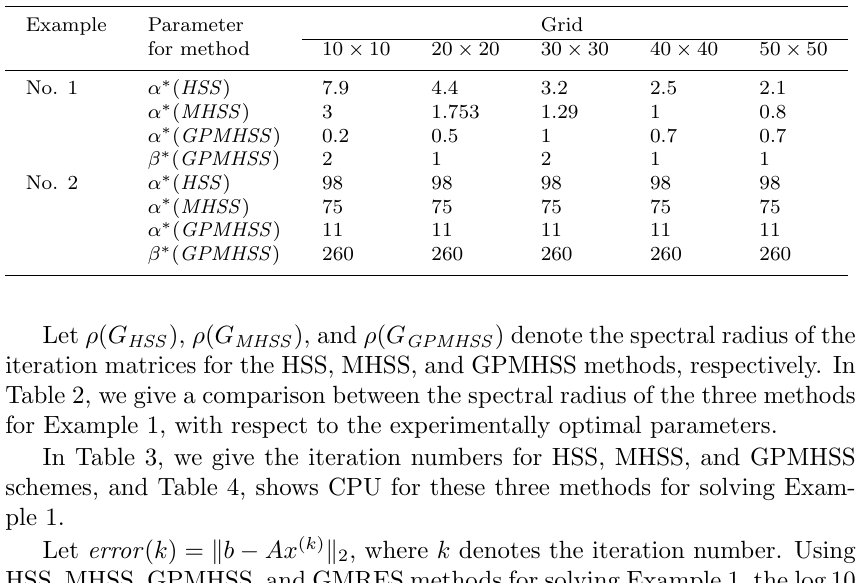
Dirichlet boundary conditions and periodic boundary conditions, respectively,